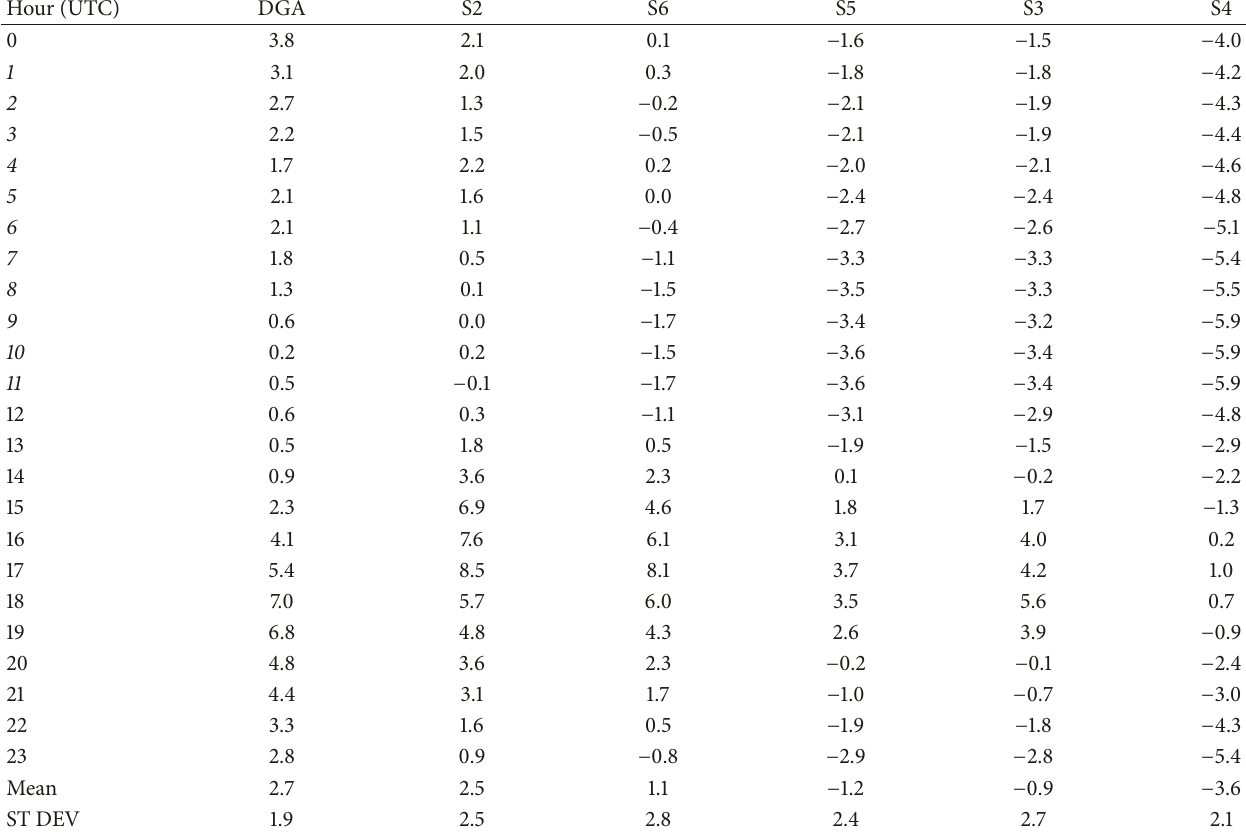
Table 2: Comparison of surface air temperature ( ∘ C) mean hourly data for 22–26 March 2015 at DGA and the five Tinytag sites (2-m sensors). See Figure 1 and Table 1 for site details. Hours with nocturnal observations are highlighted in italic (https://www.timeanddate.com/ sun/chile/santiago), here illustrated in